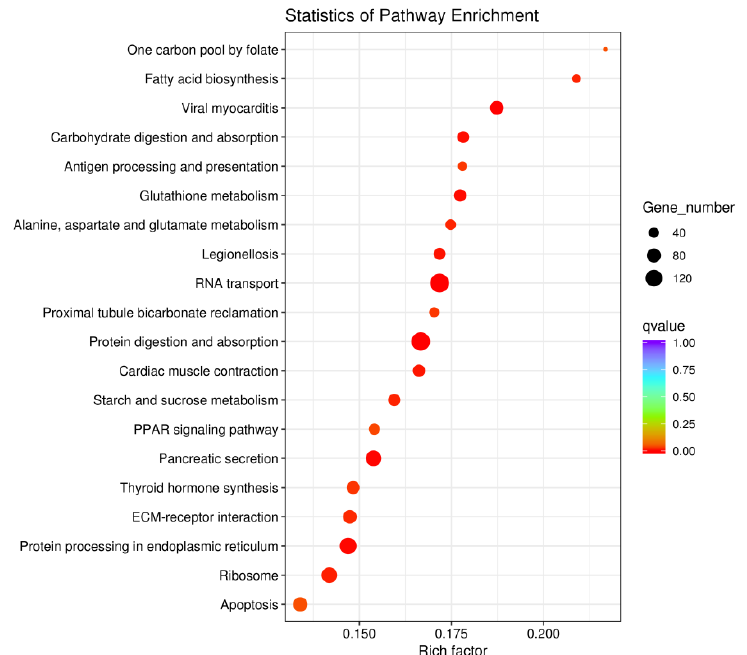
Figure 11. Scatterplot of DEGs between wild-type and domesticated Daphniopsis tibetana enriched in the KEGG pathways.